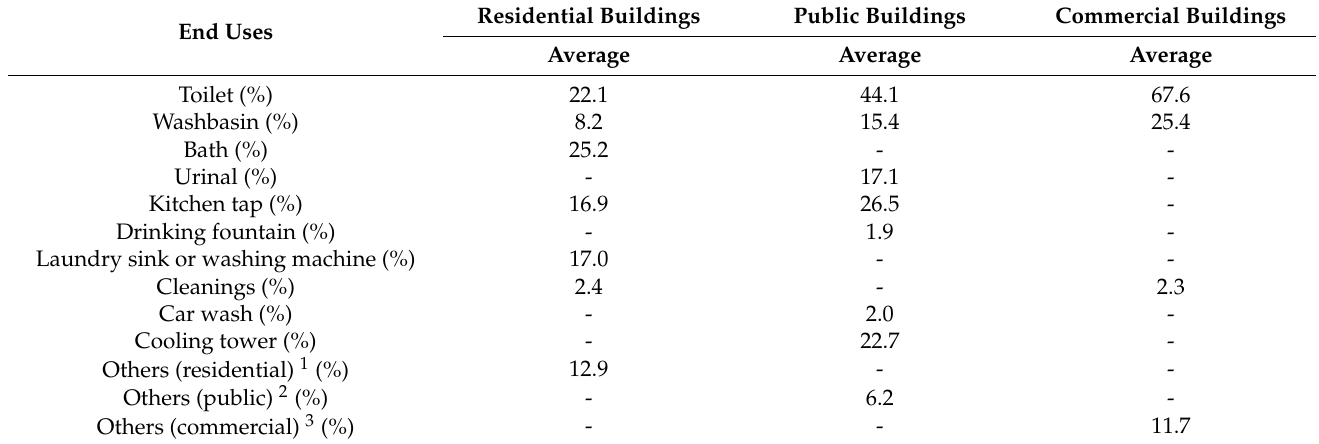
Table 6. Water end uses of case studies in residential, public, and commercial buildings. Based on Teston et al.